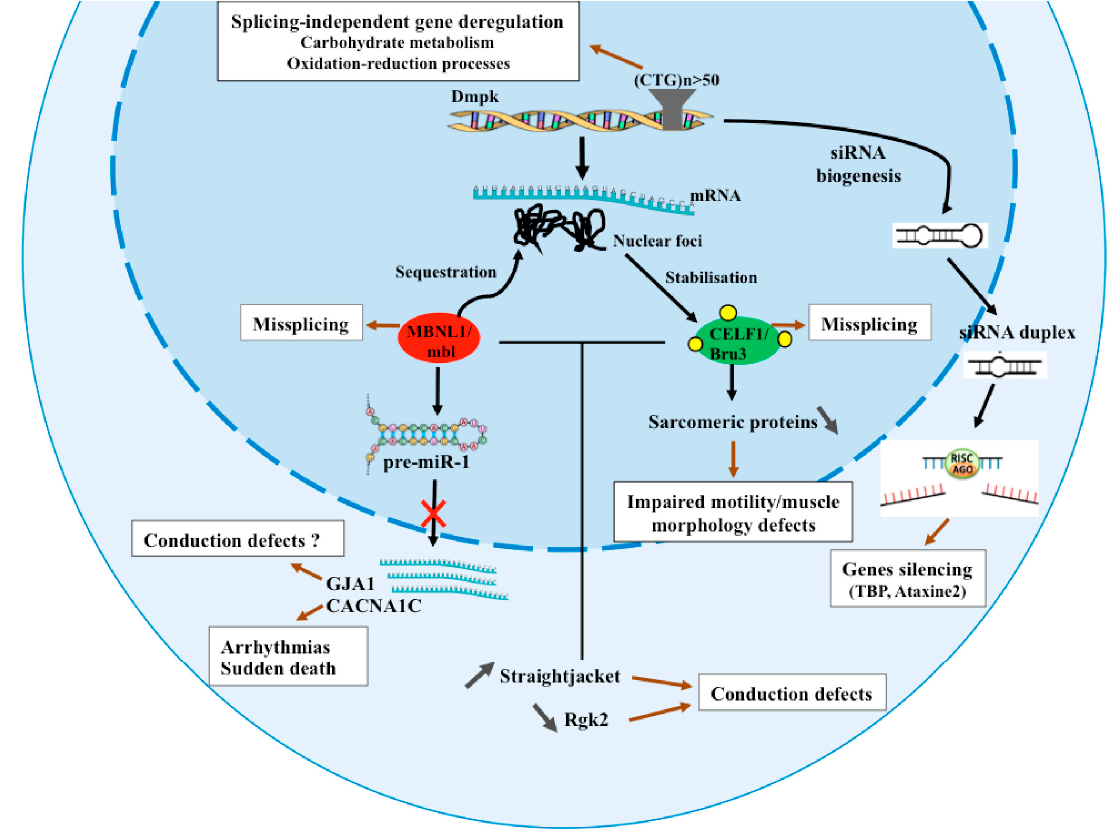
Figure 1. Molecular mechanisms underlying DM1 pathology identified in Drosophila . DM1 is caused by microsatellite repeat expansions ( n > 50 CTG repeats) in 3’UTR region of DMPK gene. Mutant DMPK transcripts are retained in the nucleus and form nuclear foci that sequester MBNL1/Mbl and stabilize CELF1/Bru3 proteins leading to missplicing. Bru3 stabilization also induces down-regulation of sarcomeric proteins associated with impaired motility and muscle morphology defects [59], whereas loss of MBNL1/Mbl blocks pre miR-1 processing [53] leading to up regulation of its target genes such as GJA1 and CACNA1C suggested as associated with conduction defects and arrhythmias/sudden death, respectively [45]. Both Bru3 stabilization and Mbl sequestration induce up regulation of Stj and down regulation of Rgk2 expression associated with conduction defects [47]. CTG repeats could be transcribed in both directions leading to CAGn–CUGn double stranded complexes and formation of siRNA duplex that interact with RISC complex to target the expression of genes containing CAG repeats, such as Ataxin-2 ( ATXN2 ) and TATA binding protein ( TBP ) [38]. Long CTG repeats induce down regulation of genes in a splicing independent manner including genes involved in carbohydrate metabolism and oxidation-reduction processes [52].